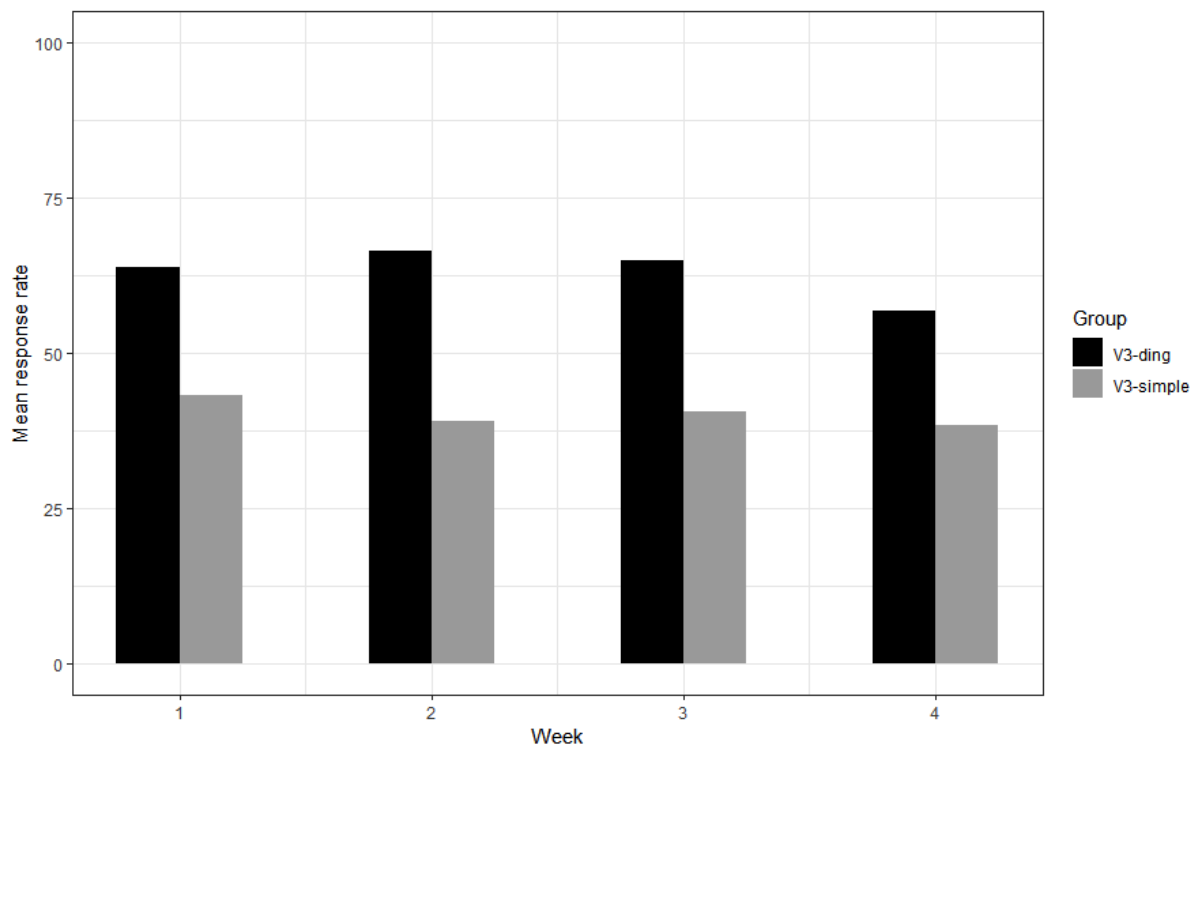
Figure 5. Chart depicting mean weekly response rate comparison between groups version 3 (V3)-simple and V3-ding for participants in Field Trial 2. V: